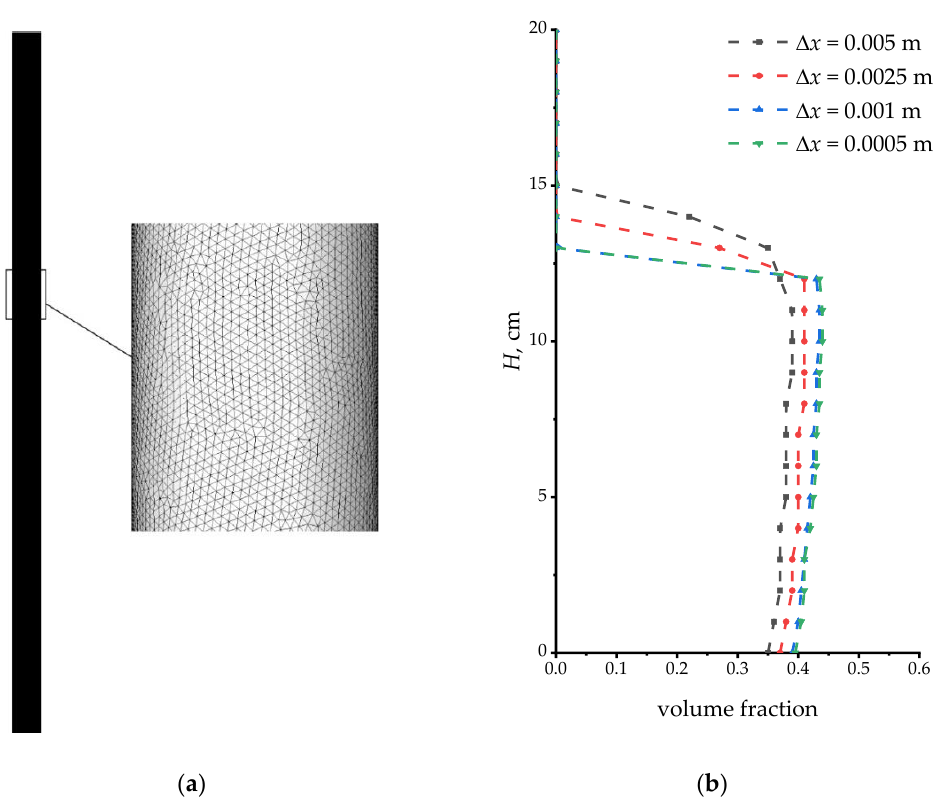
Figure 2. Mesh: ( a ) graphical example; ( b ) definition of optimal x 